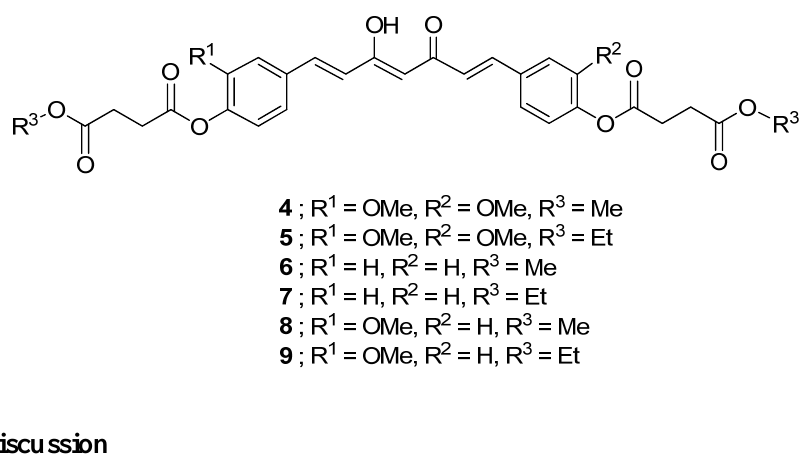
Figure 2. Structures of succinate prodrugs of